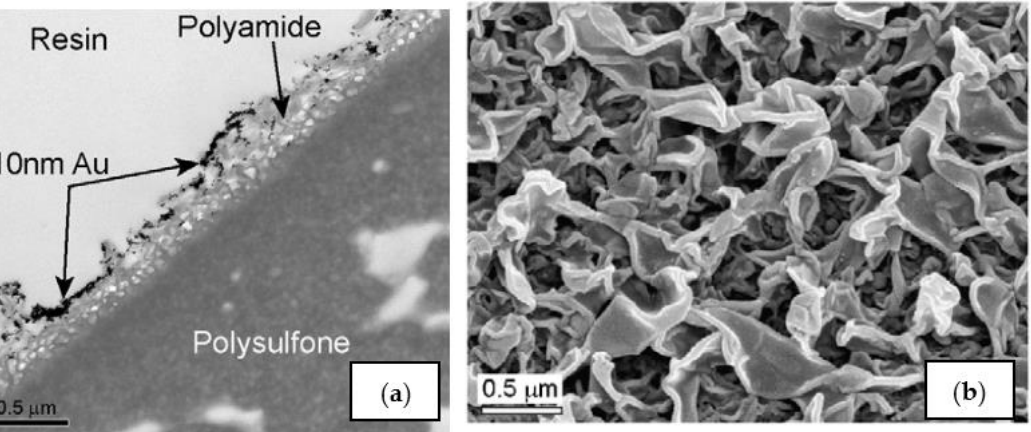
Figure 1. TEM cross-section of a typical RO membrane (ESPA3, Hydranautics) previously used in a filtration experiment with 10 nm gold nanoparticles [33]. ( a )TEM of the membrane cross-section. Gold nanoparticles are used to obtain sufficient contrast for imaging. ( b ) SEM of the polyamide top surface showing the typical rough ridge and valley structure from